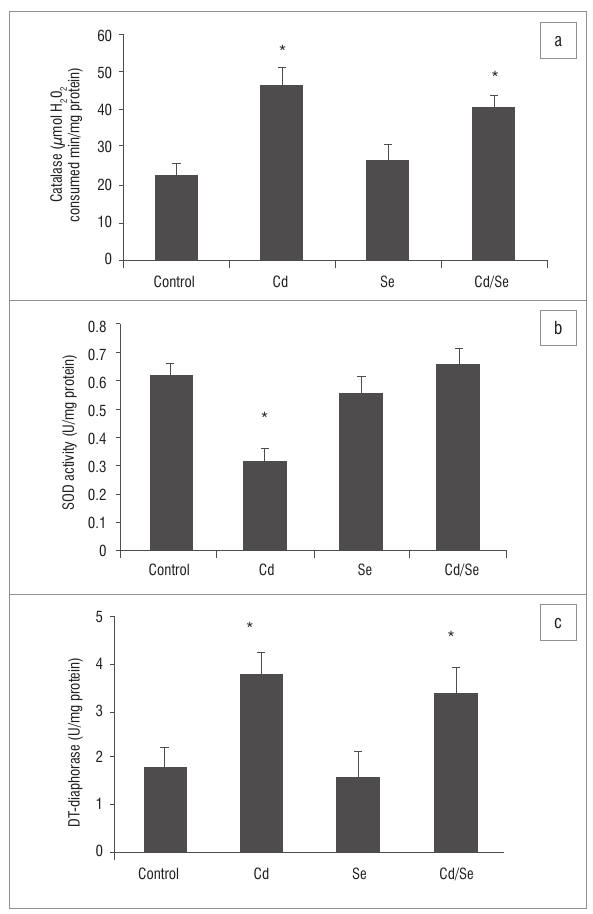
*Statistically significantly different from control at p<0.05. Figure 7: Mean±SD (a) catalase, (b) total superoxide dismutase (SOD) and (c) DT-diaphorase activities in the testes of male rats ( n =5) that received cadmium (1.67 mg/kg cadmium chloride in saline), selenium (0.23 mg/kg sodium selenite solution), cadmium and selenium (Cd/Se; 1.67 mg/kg cadmium chloride in saline and 0.23 mg/kg sodium selenite solution) or saline (control) daily (IP) for 15 days. Mean±SD esterase activities in the cytosol of the livers, kidneys and testes of rats after 15 days of exposure to saline (control) cadmium, selenium or cadmium and selenium Control